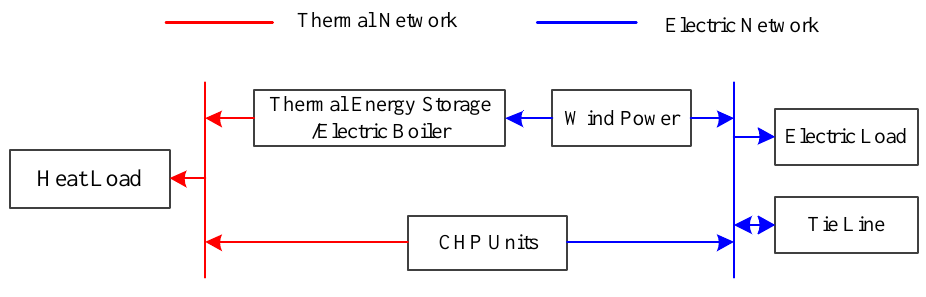
Figure 1. System structure of a microgrid integrating electrical and thermal